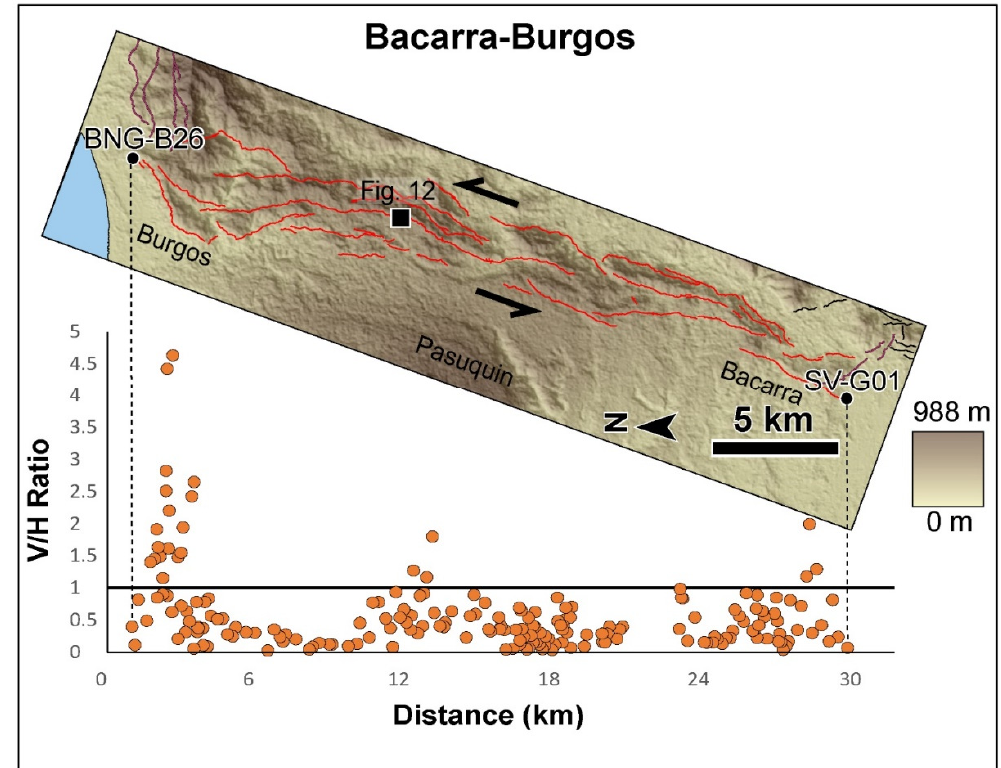
Figure 10. Map of the trace from Bacarra to Burgos (labeled ‘c’ in Figure 2A) above the offset plot for this part of the Vigan-Aggao Fault. The Bacarra-Burgos segment is traced in red, while the northern portion of the Sarrat-Vintar-Bacarra segment is traced in black. The transition between segments is traced in violet.